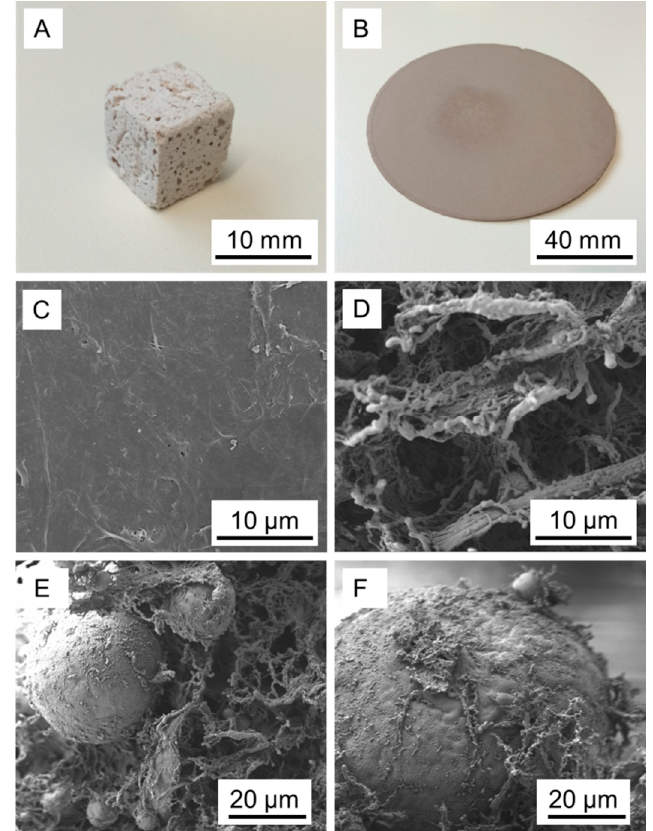
Figure 5. Optical appearance of an oven-dried porous polyester-MFLC compound ( A ) compared to an MFLC nanopaper ( B ); SEM images of an MFLC nanopaper surface ( C ) compared to the network-like structure of MFLC dried in the presence of unsaturated polyester ( D ). SEM images of cured spheres of polymer embedded in MFLC network ( E , F ).